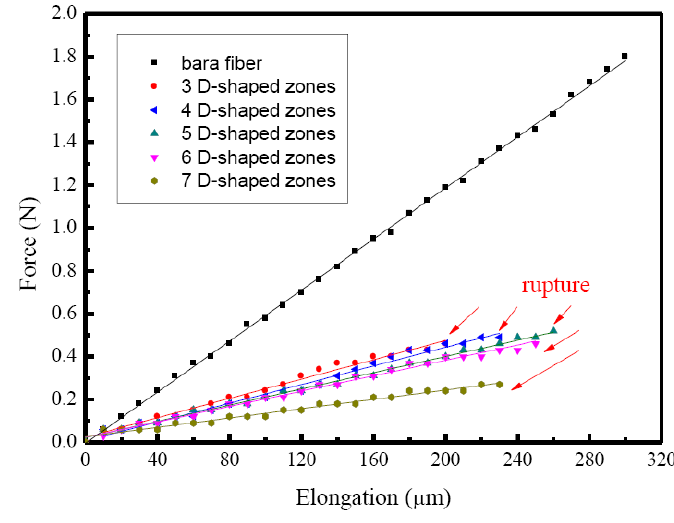
Figure 7. The tensile testing curve diagrams for a bare optical fiber and five different D-shaped